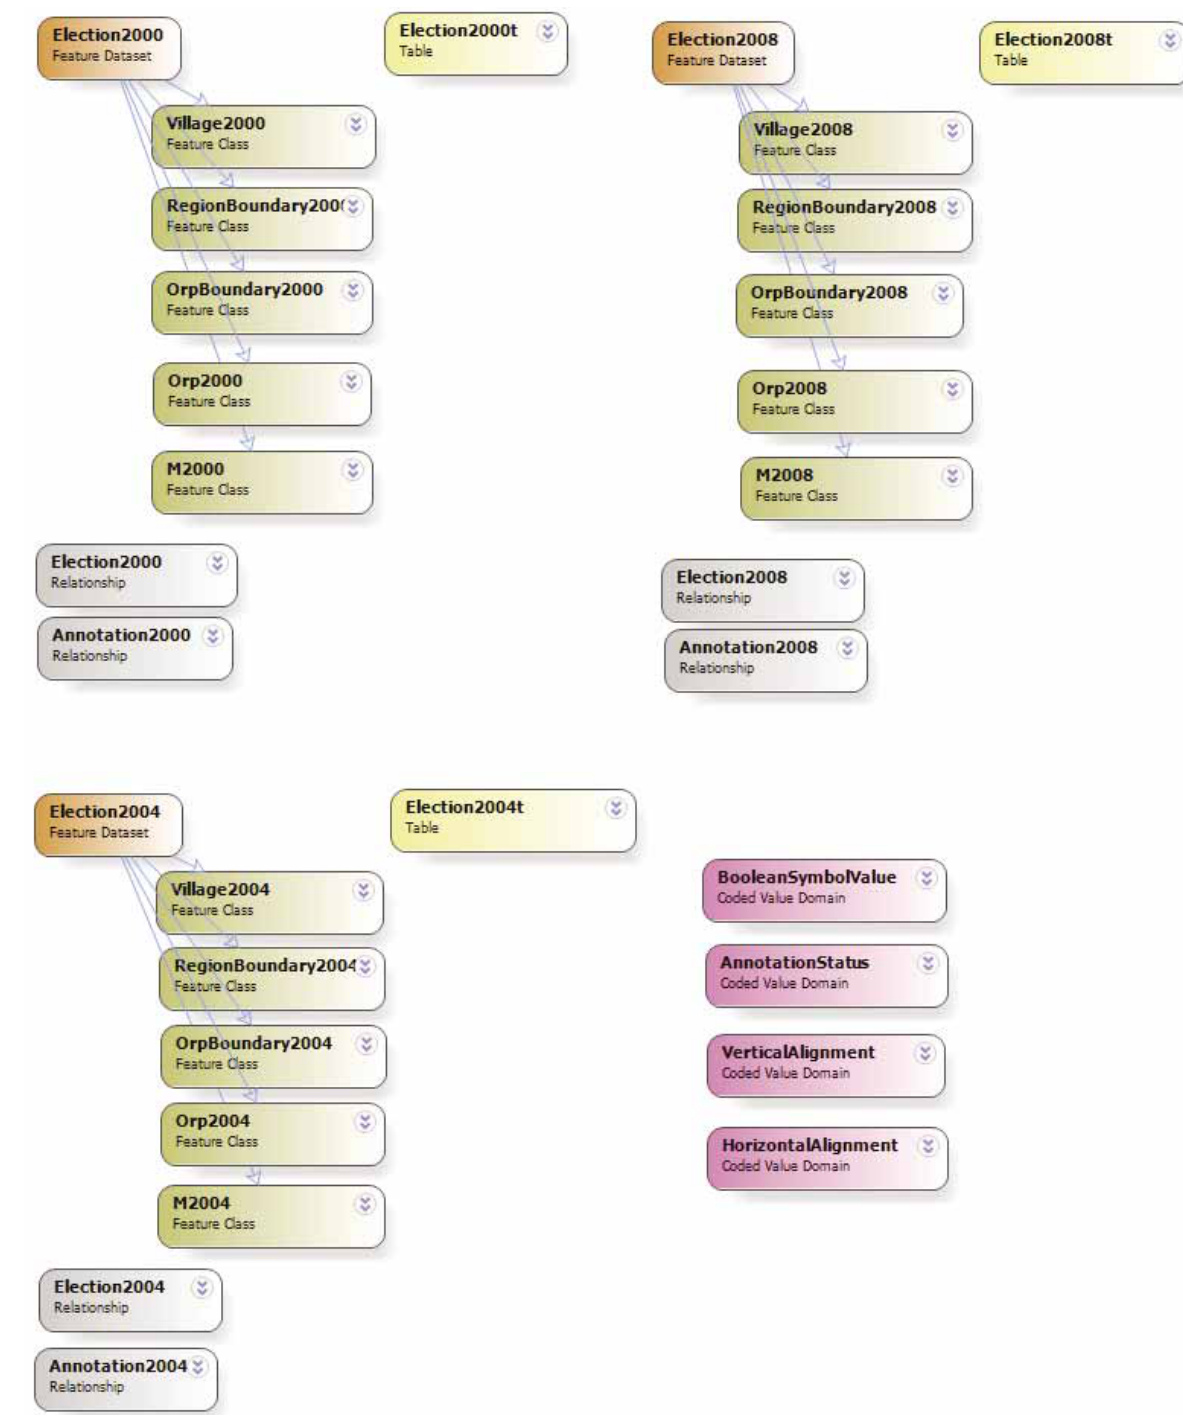
Fig. 3. Database model of the “Atlas” in ArcGIS